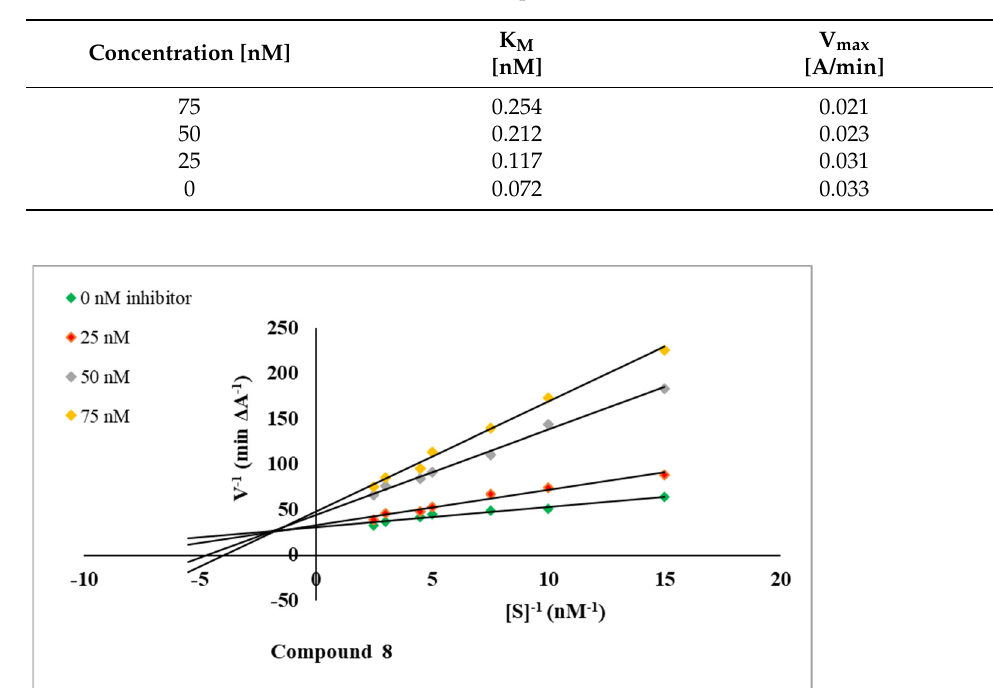
Table 1. In vitro inhibitory concentration of the new compounds and against AChE and BChE (IC 50 , µ M), selectivity, and the radical scavenging effect IC 50 (DPPH). Compound